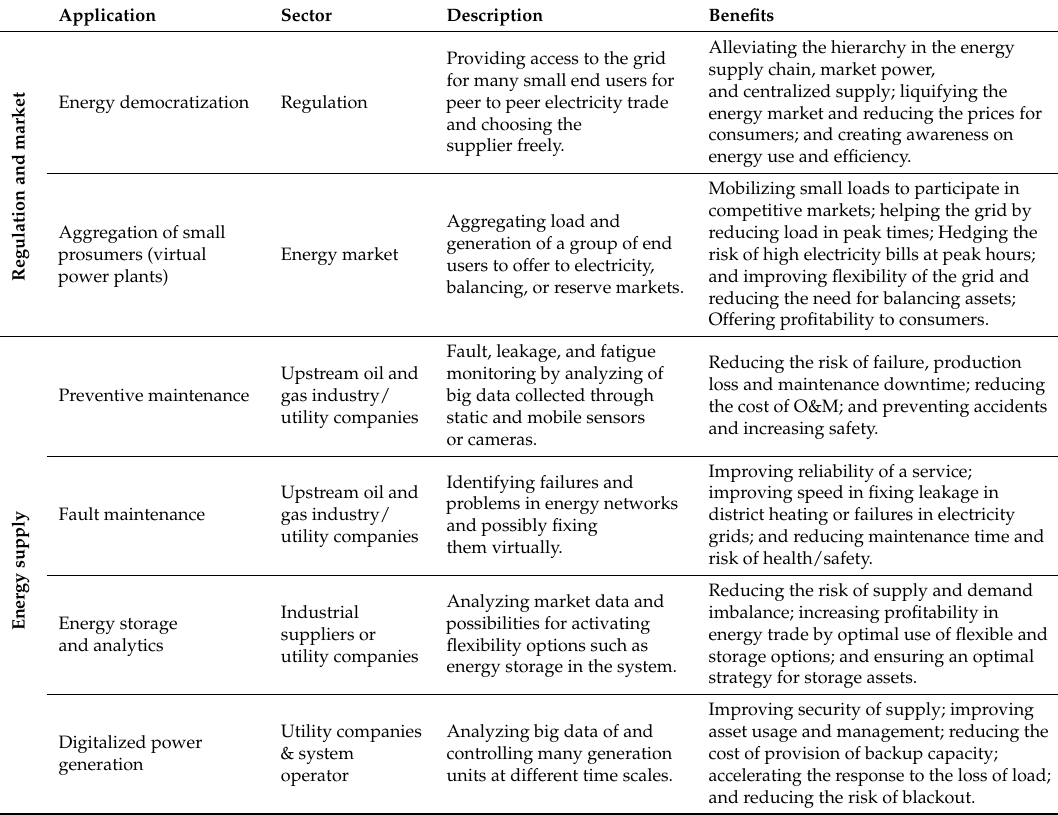
Table 2. Applications of IoT in the energy sector (1): regulation, market, and energy supply